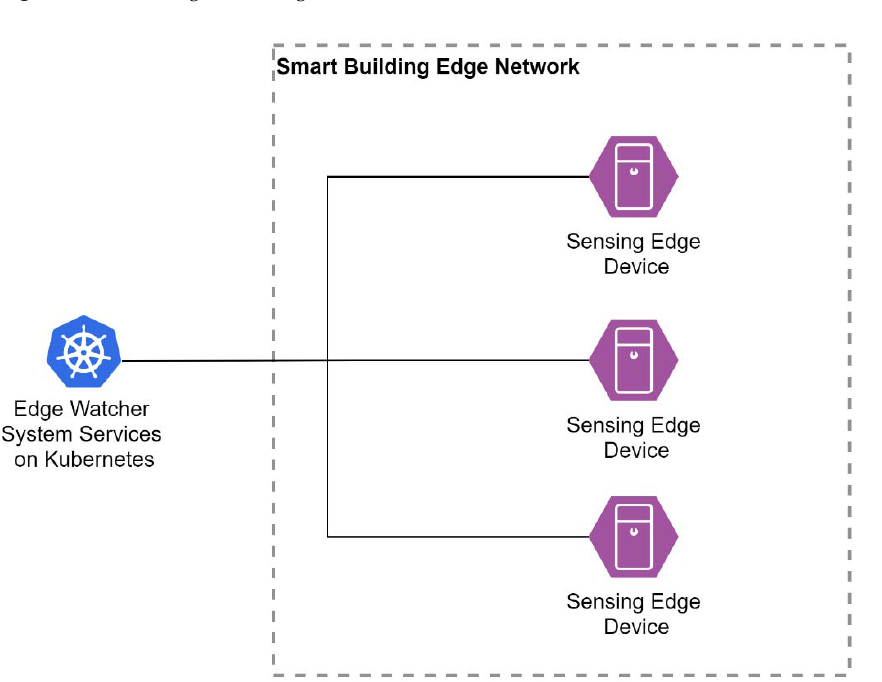
Figure 4. EWS design with sensing edge devices.